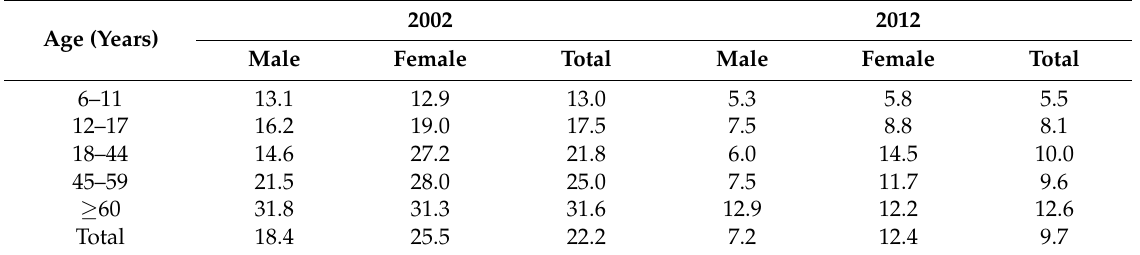
Table 6. Comparison of anemia prevalence rates of six years and older Chinese rural residents between 2002 and 2012